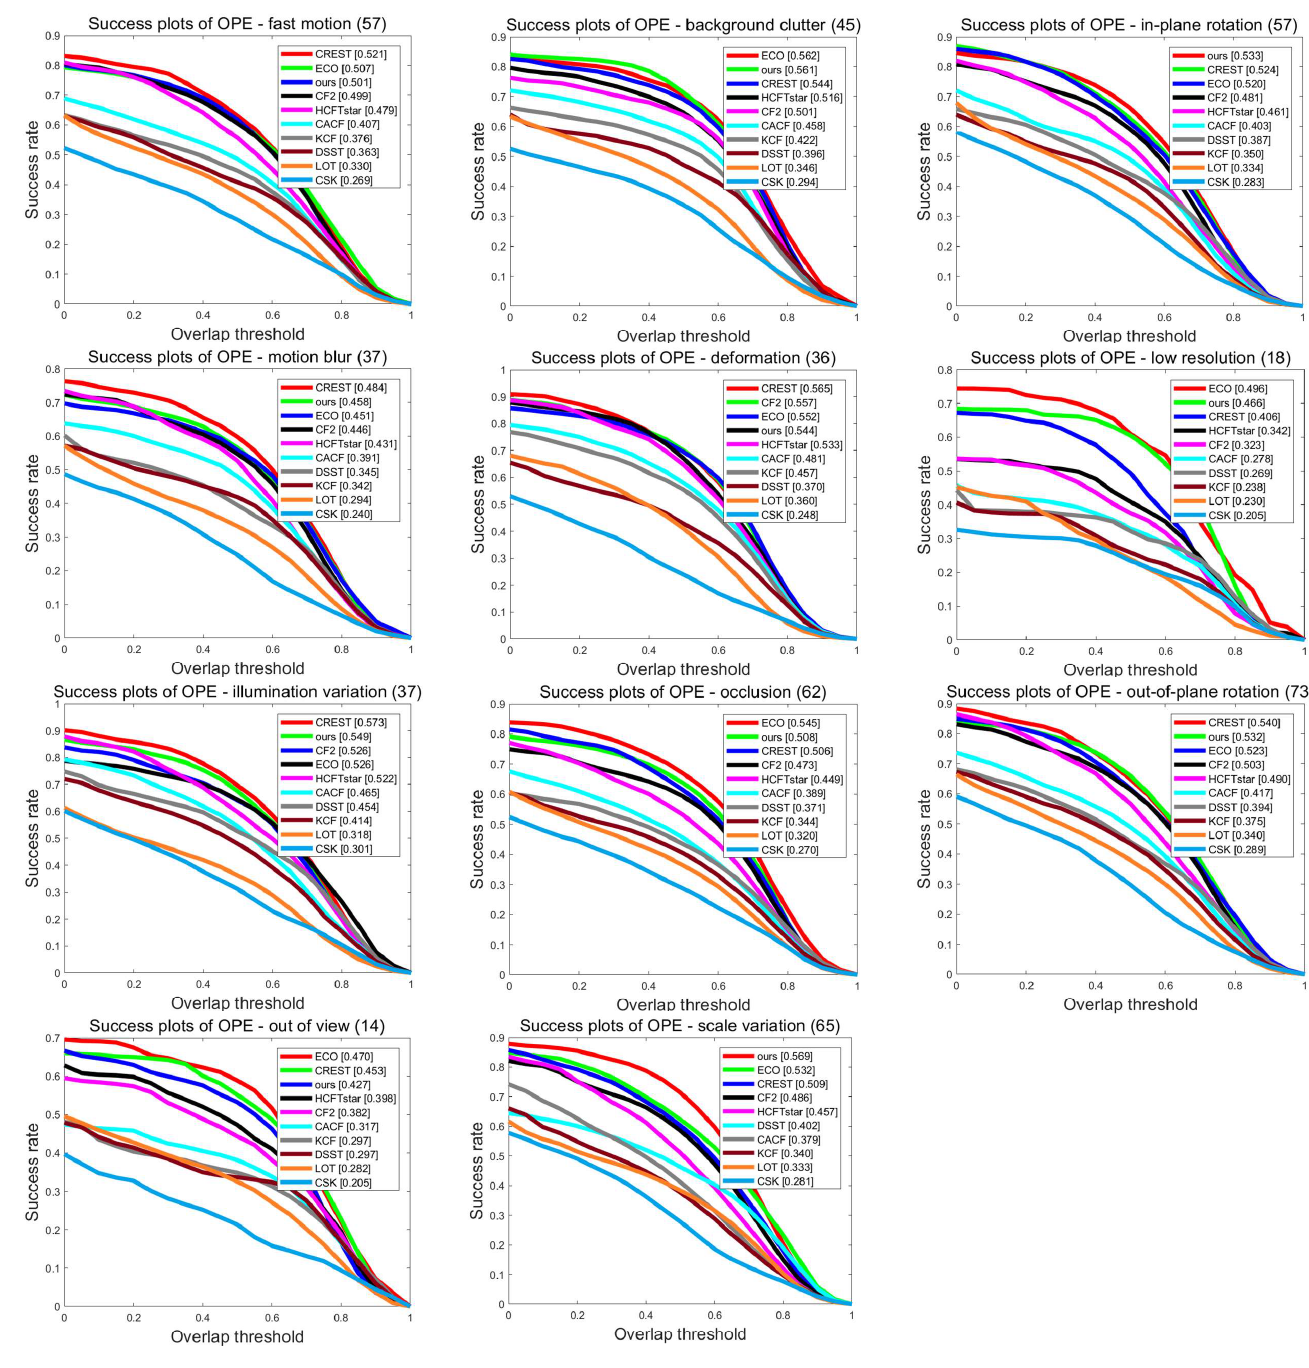
Figure 11. Comparison of 11 attribute challenge